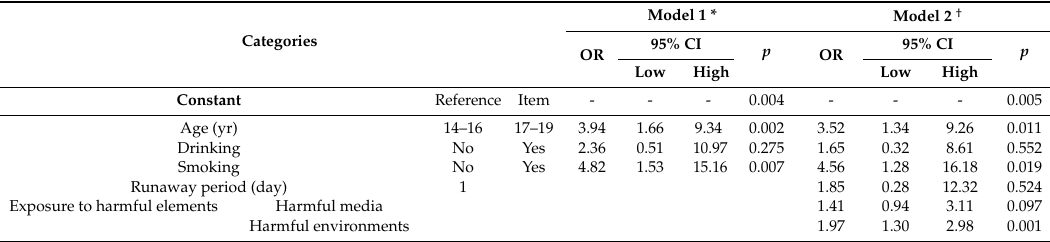
Table4. Logisticregressionpredictingrunawayfemaleat-riskadolescents’sexualintercourseexperience levels ( N =